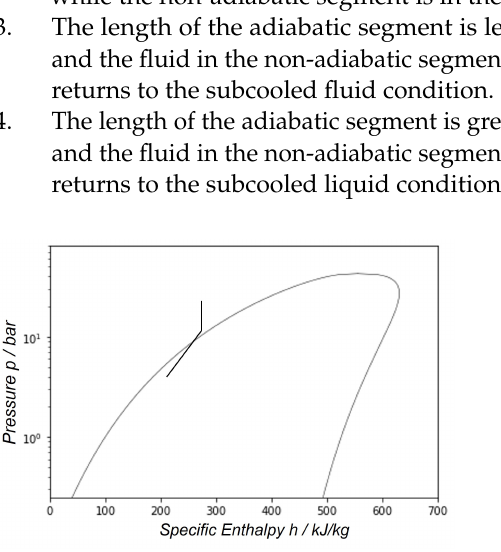
Figure 4. P-h diagram of the behaviour of the fluid inside the capillary tube when the adiabatic stroke length is shorter than single-phase length.